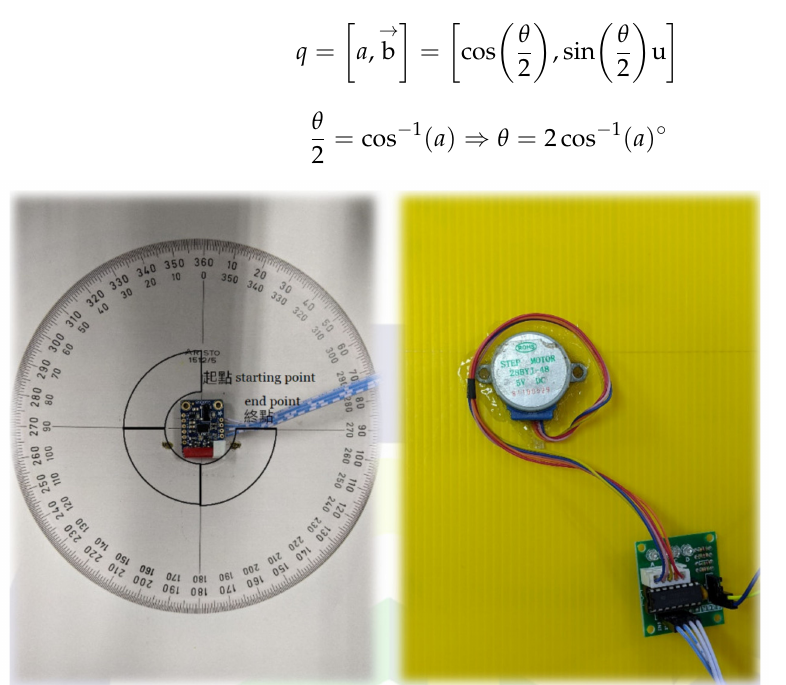
Figure 9. Experimental environment set-up—front ( left , IMU is shown) and back ( right , stepping motor & drive circuit is shown) of the acrylic